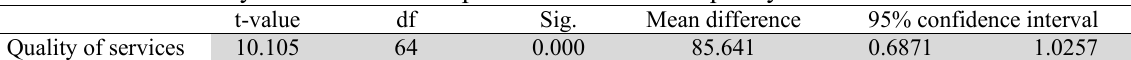
The results of one-way test on relationship between CRM and quality of services. t-value df Sig. Mean difference 95% confidence interval Quality of services 10.105 64 0.000